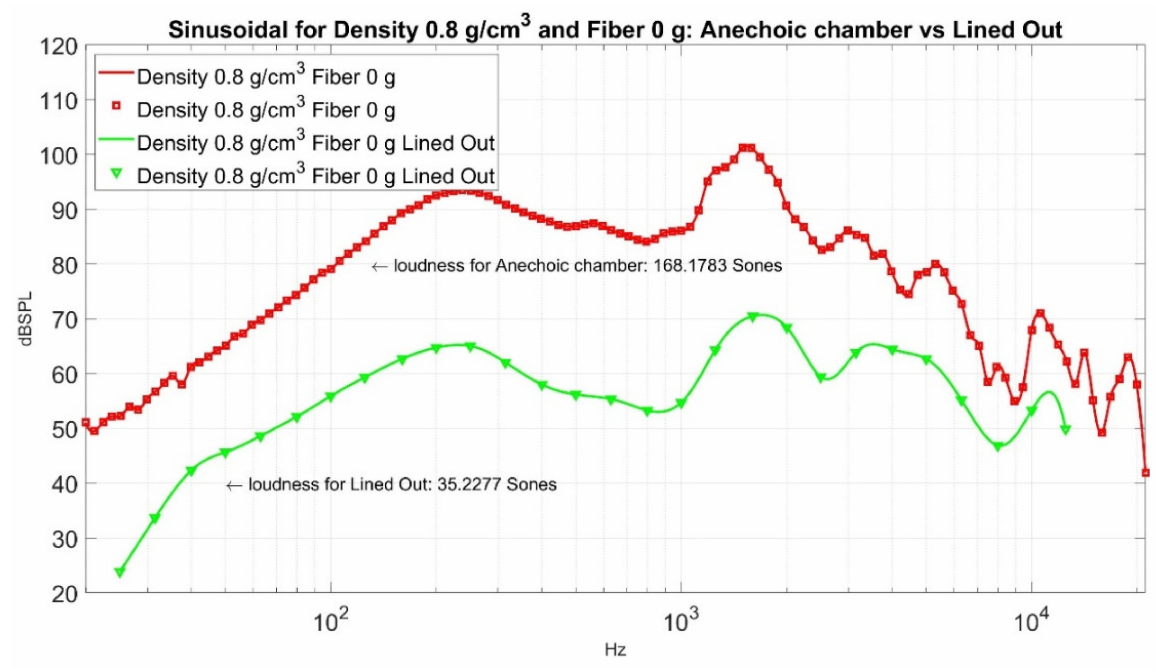
Figure 9. The sound pressure level curves for Density 0.8 g/cm 3 and Fiber 0